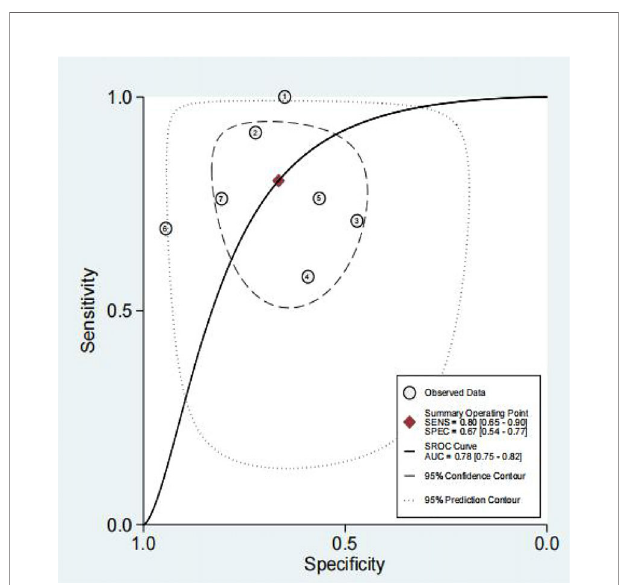
FIGURE 5 | The SROC curve of preoperative serum HE4.